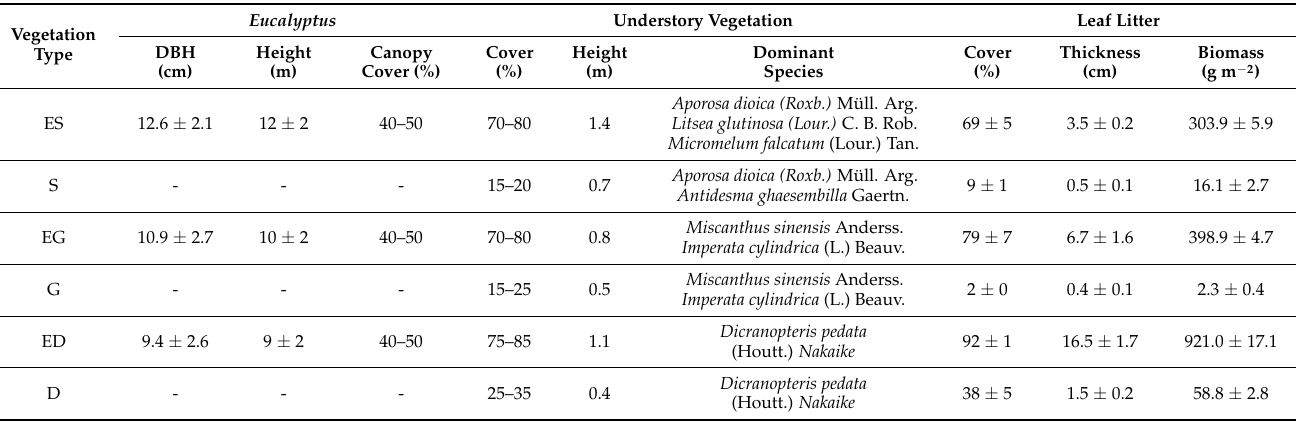
Table 1. General description of vegetation restoration with Eucalyptus and natural vegetation restora- tion without Eucalyptus .